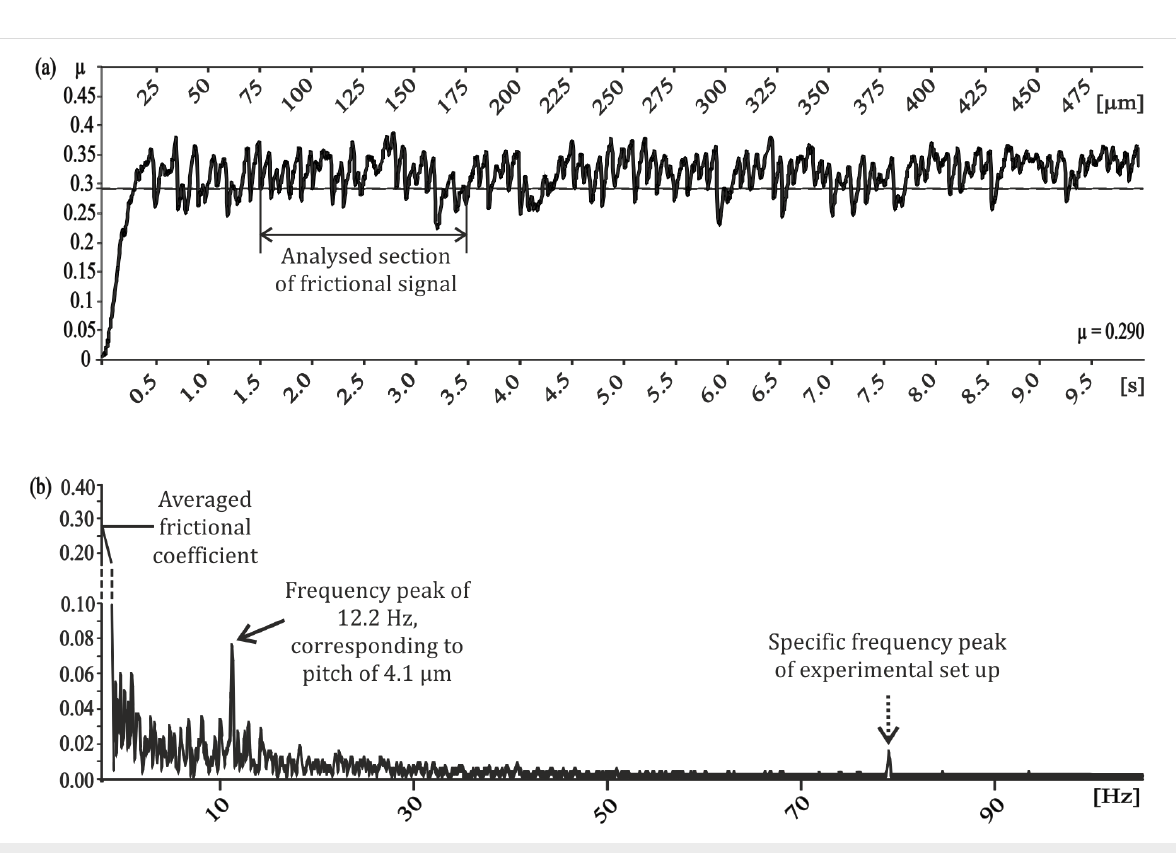
Figure 9: Example of data analysis of the frictional signal measured on the periodical groove-like polymer surface – PGMS (pitch dimension: 5 µm) perpendicular to the orientation of the microstructure, a) in spacial/time domain. Averaged frictional coefficient and exemplary selected section of fric- tional signal for data processing; b) in frequency domain based on FFT, ordinate shows single-sided amplitude spectrum – SSAS. Intersection of the graph on the ordinate presents the averaged frictional coefficient. At 12.2 Hz a dominating frequency according to a pitch of 4.1 µm can be identified. This correlates well to the pitch of 5 µm (lines and spaces of the substrate). Dotted arrow points out the resonance frequency peak, which is the prop- erty of the experimental setup, because it could be found in each combination of tribometer, glass ball, and epoxy mold